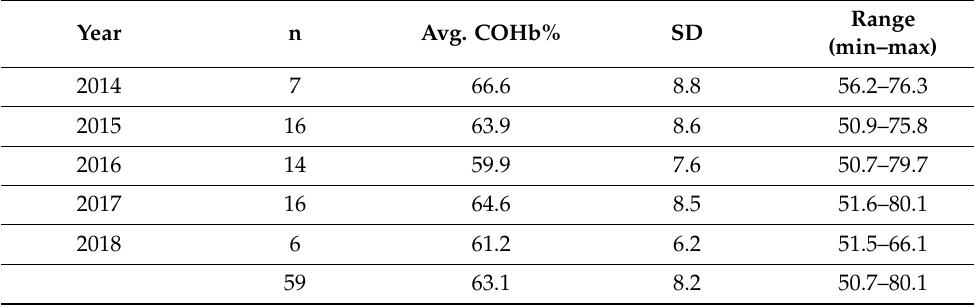
Table 2. COHb% in blood specimens of CO poisoning fatal cases (n = 59) in Kuwait.